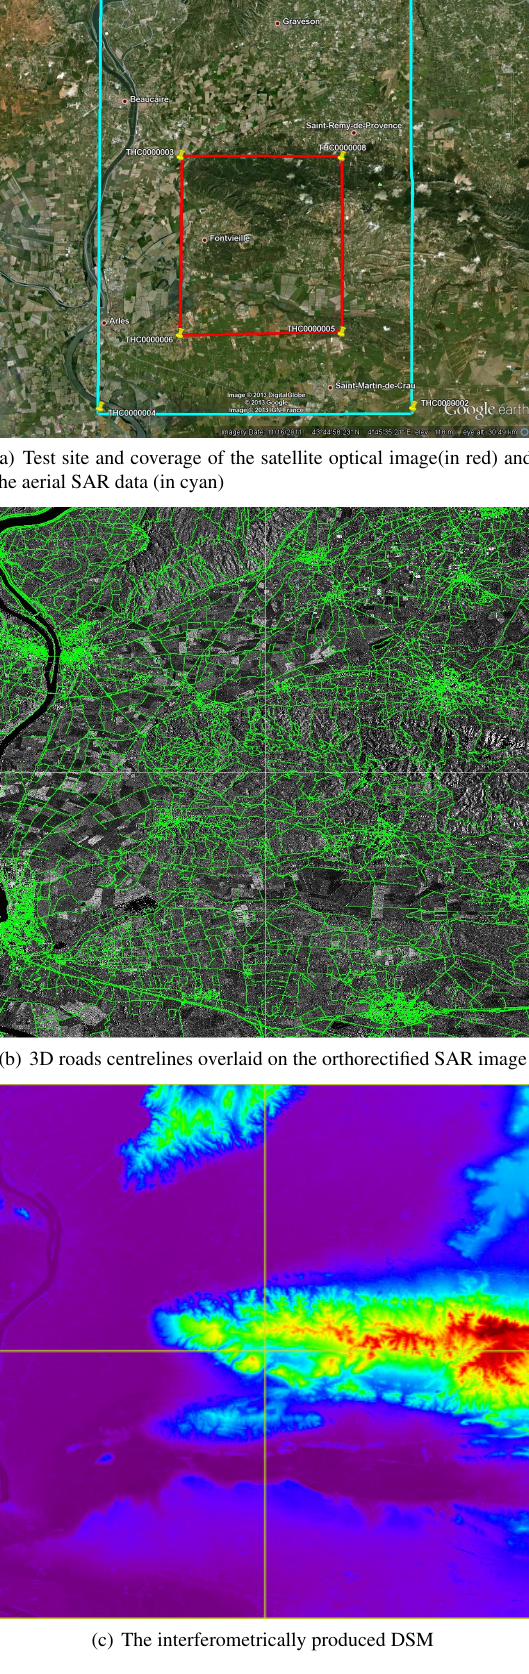
Figure 1: Test site and data